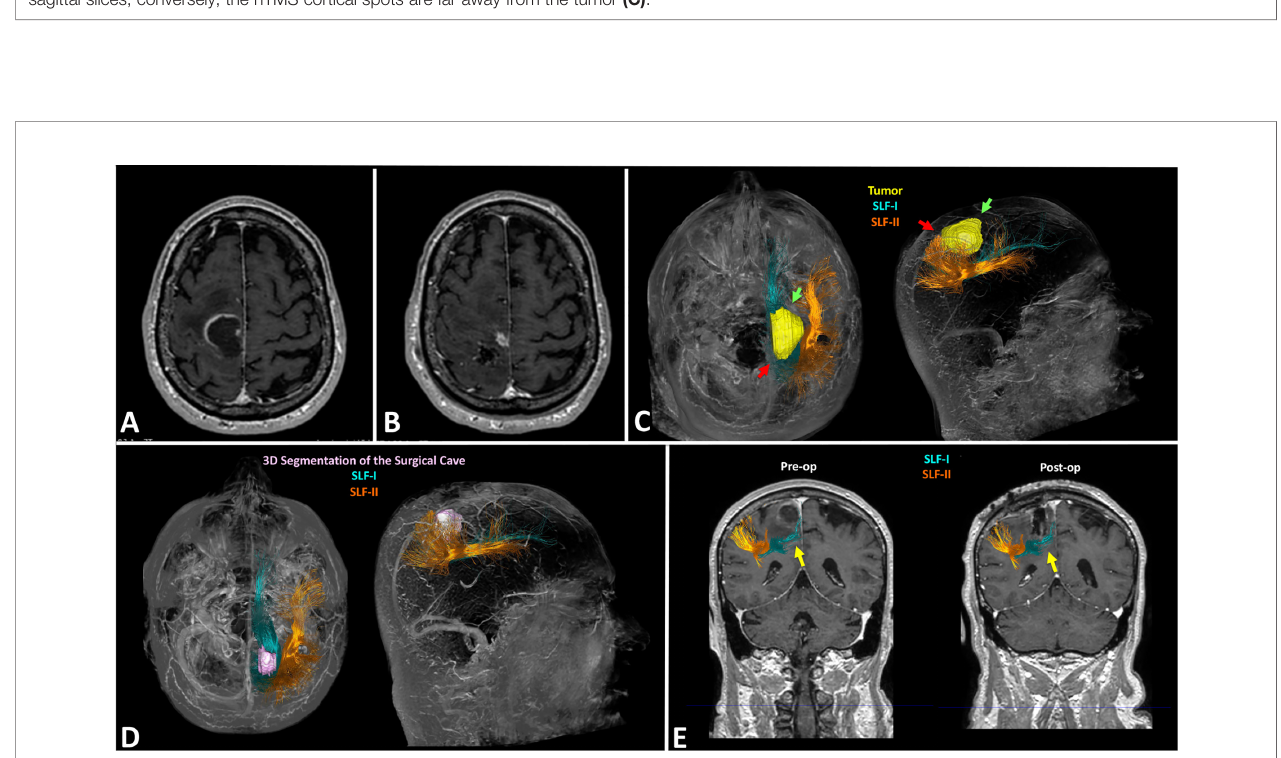
FIGURE 7 | Case example of the planning in a case of right fronto-parietal GBM (case 4 in Table 1 ). Preoperative MRI scan documenting the lesion is located in the anterior portion of the right parietal lobe and in fi ltrates also the primary motor cortex (A) ; postoperative MRI scan documenting the subtotal resection of the lesion: neurosurgeons removed only the portion located in the right parietal lobe, while they didn ’ t resect the portion in fi ltrating the motor cortex (B) ; preoperative reconstruction of the VS network showing the posterior portion of the lesion is close to the blue fi bers of the SLF-I indicated by the red arrows: this induced a change of surgical strategy leading neurosurgeons to start resection from the antero-lateral portion of the tumor indicated by the green arrows, just medially to the orange fi bers of the SLF-II (C) ; postoperative DTI fi ber tracking showing the 3D rendering of the surgical cave in pink, and the preserved blue fi bers of the SLF-I and orange fi bers of the SLF-II (D) ; coronal section showing the preservation of the SLF-I and II, especially the blue fi bers of the SLF-I running medial to the surgical cave (E)